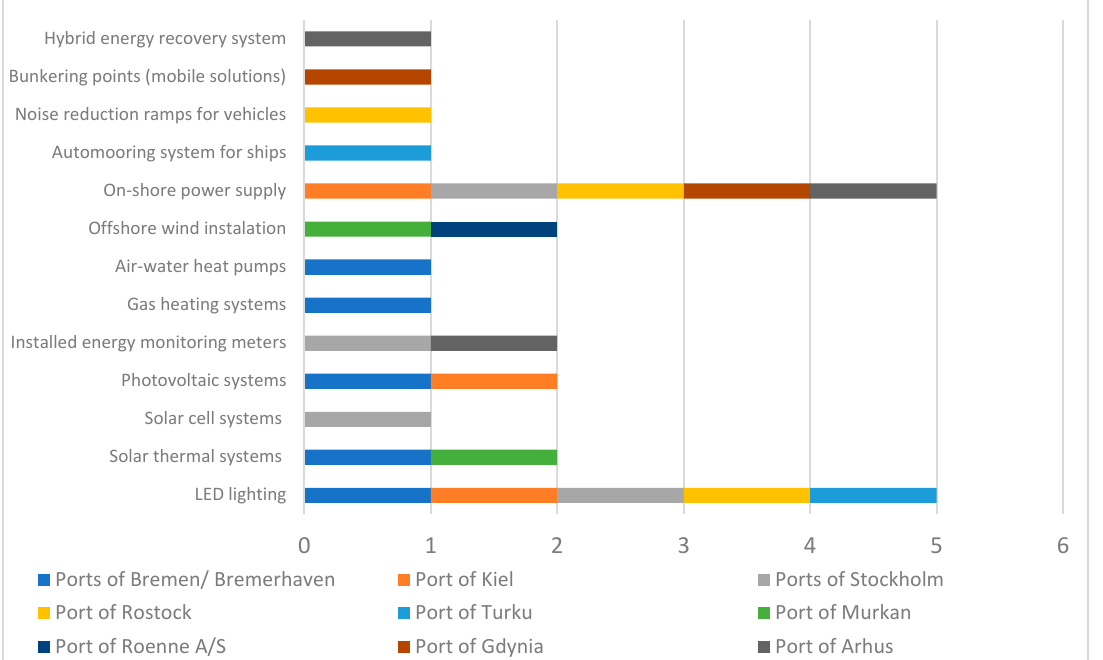
Table 3. Power supply services for cruise ships at berth in the surveyed ports in Northern Europe.